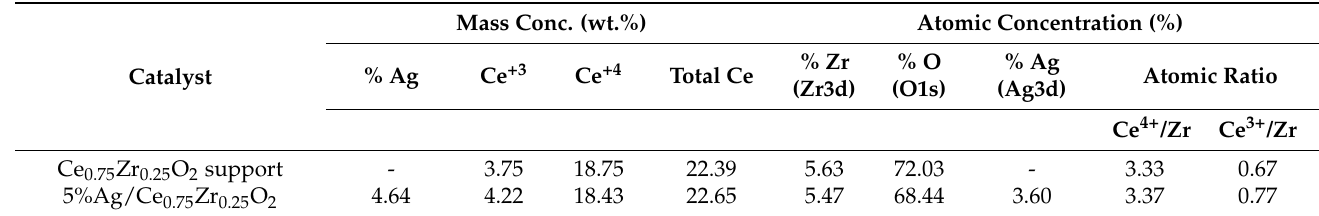
Table 2. Composition parameters obtained from XPS